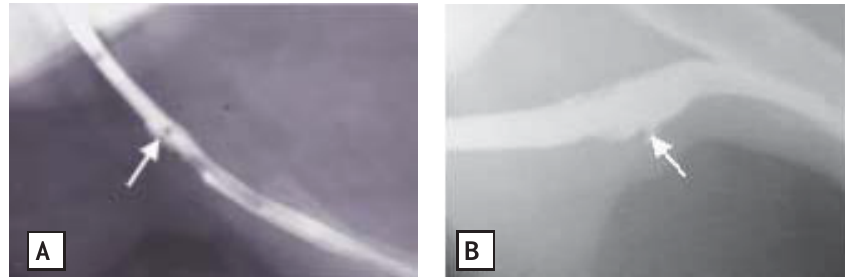
FIGURA 2 - Aspecto radiográfico da uretra peniana de cão submetida a reconstrução de sua parede ventral com fragmentos de mucosa bucal aos 40 dias de pós-operatório, evidenciando